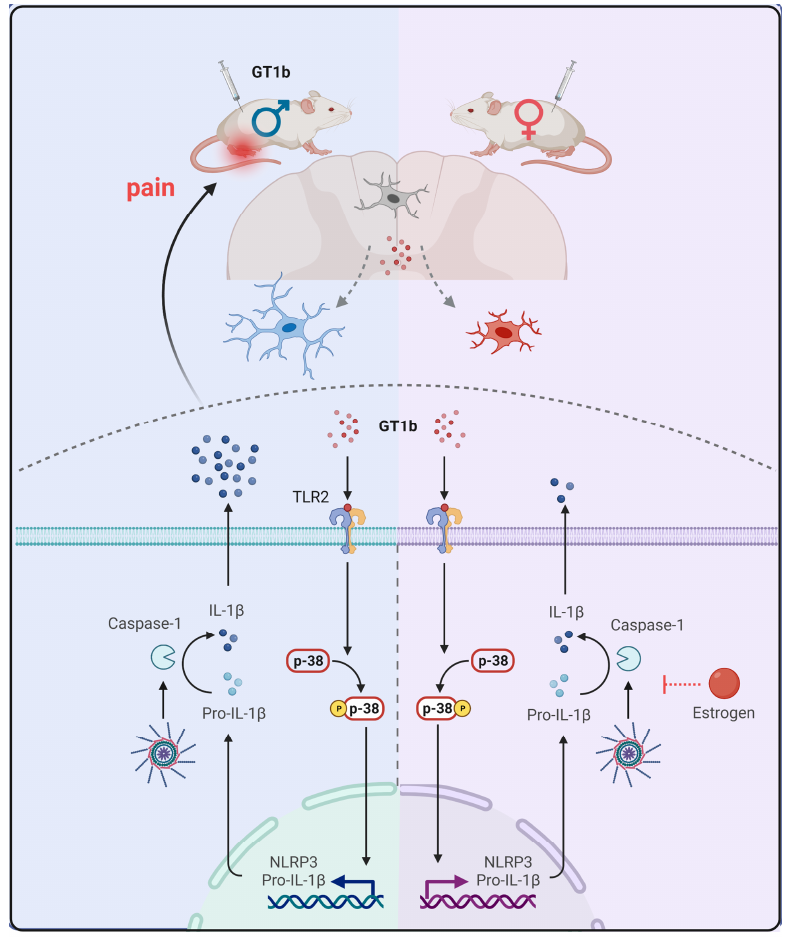
Figure 5. Sexual dimorphic mechanism of GT1b-induced pain central sensitization.